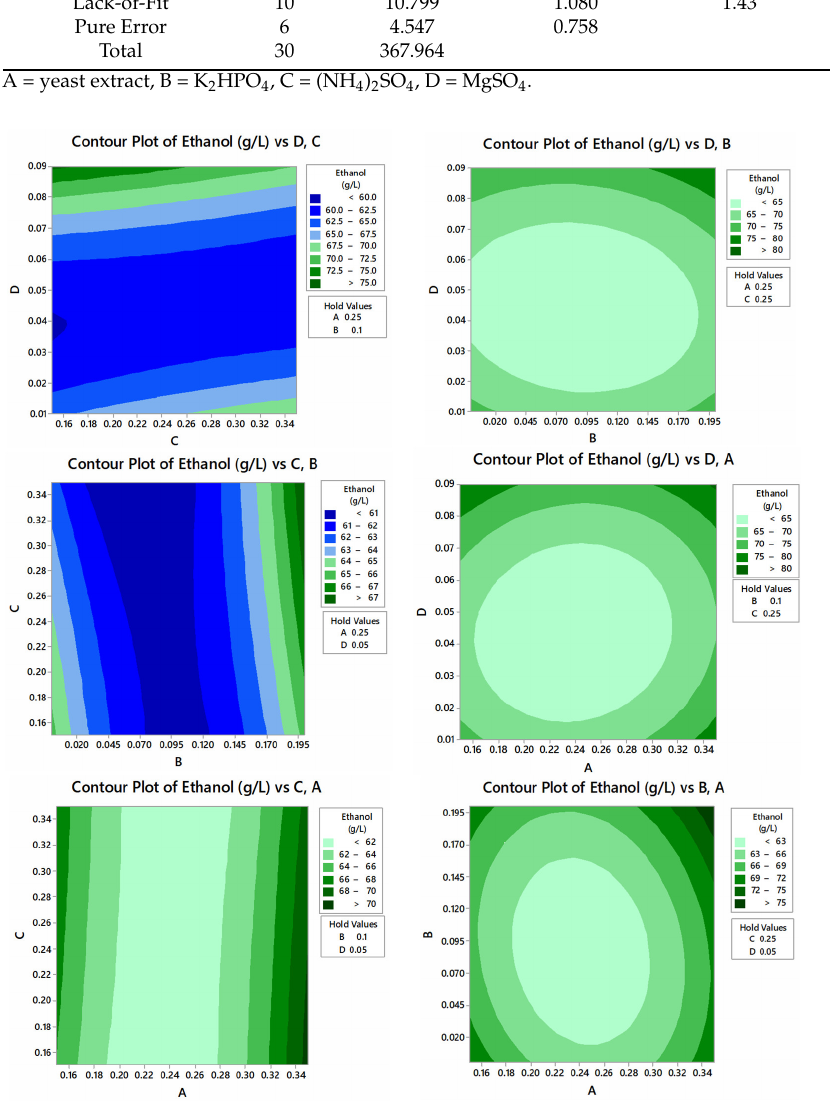
Figure 11. Contour plots of interactions of yeast extract, K 2 HPO 4 , (NH 4 ) 2 SO 4 , and MgSO 4 for ethanol production.